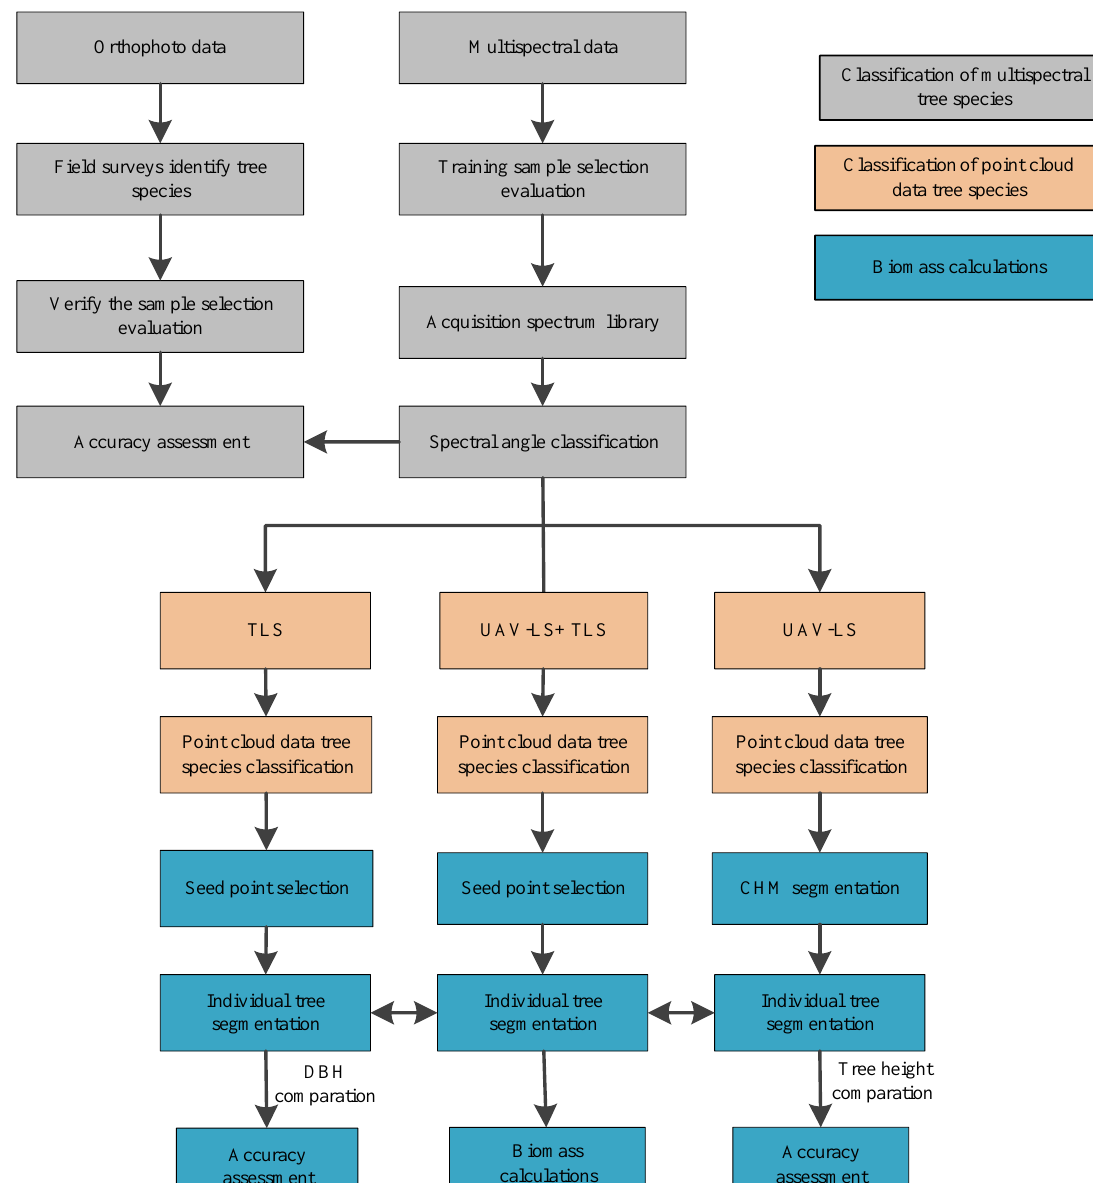
Figure 3. Flow of individual tree biomass calculation.